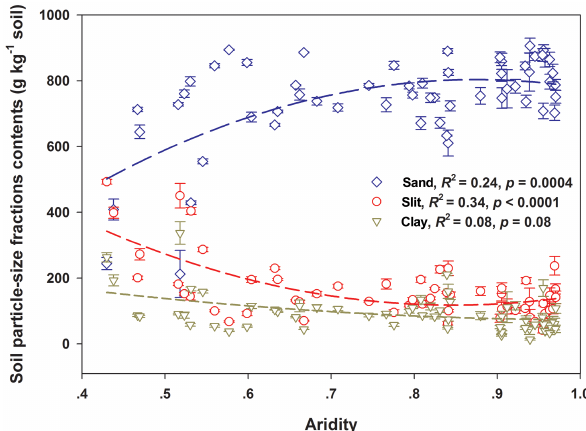
Figure 1. The relationships of soil particle–size fractions contents with aridity differed, with positive correlation between sand content and aridity, negative correlation between silt content and aridity, and no significant relationship between clay content and aridity. Data are presented as mean ± 1SE ( n =